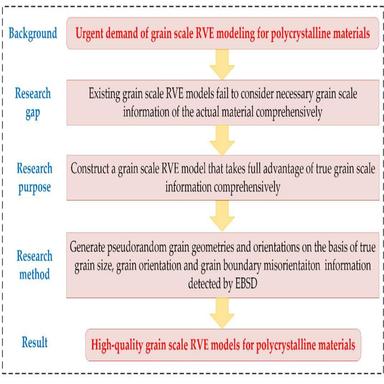
Framework of current research work.